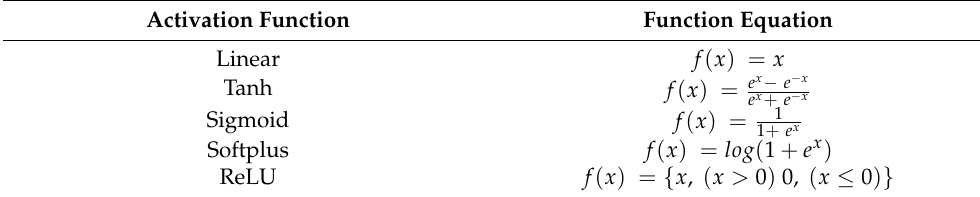
Table 1. Mathematical expression of common activation